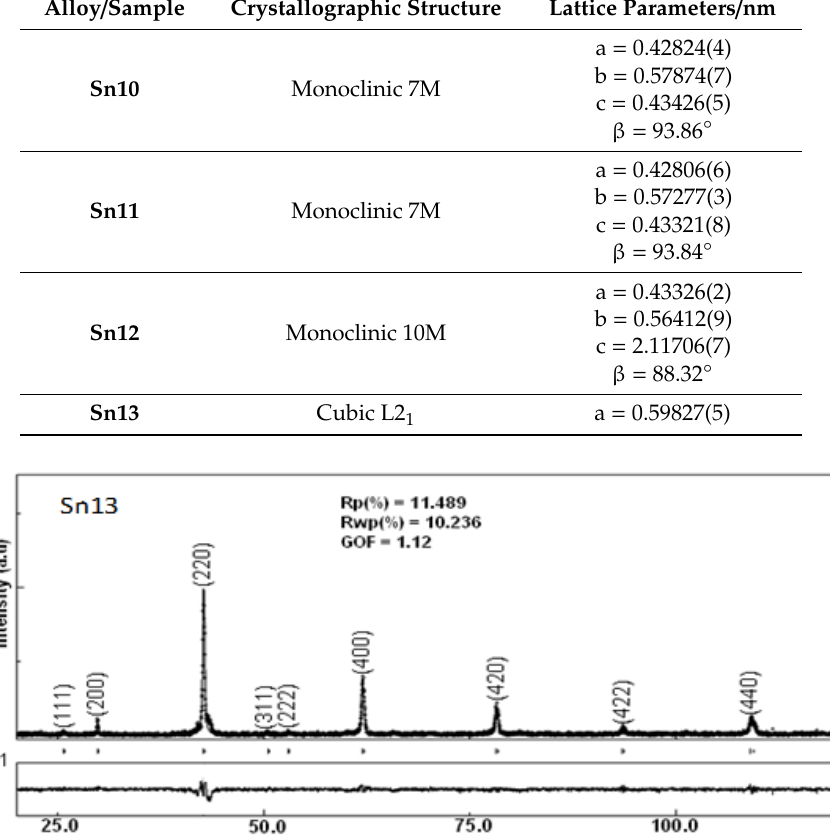
Table 1. Crystallographic parameters of samples labeled as Sn10, Sn11, Sn12, and Sn13.